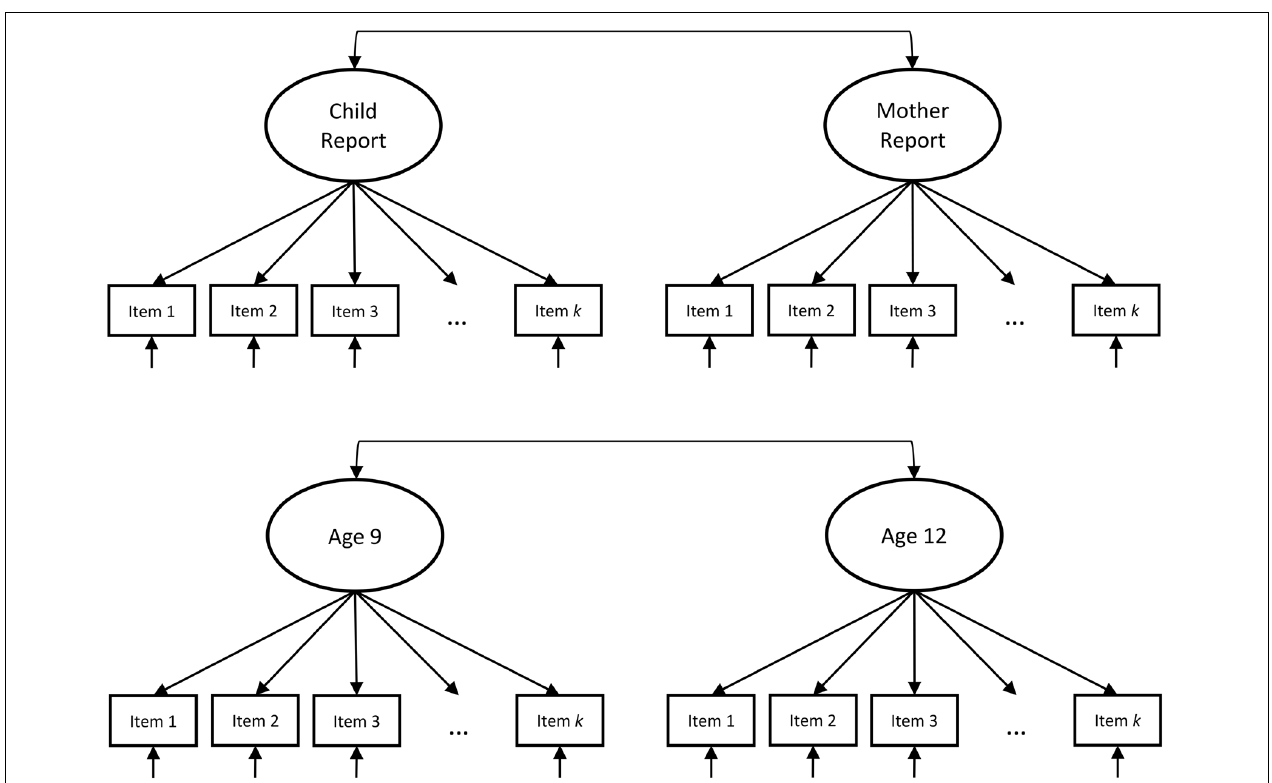
FIGURE 1 | Schematic configural invariance models tested for inter-informant models (top) and across time